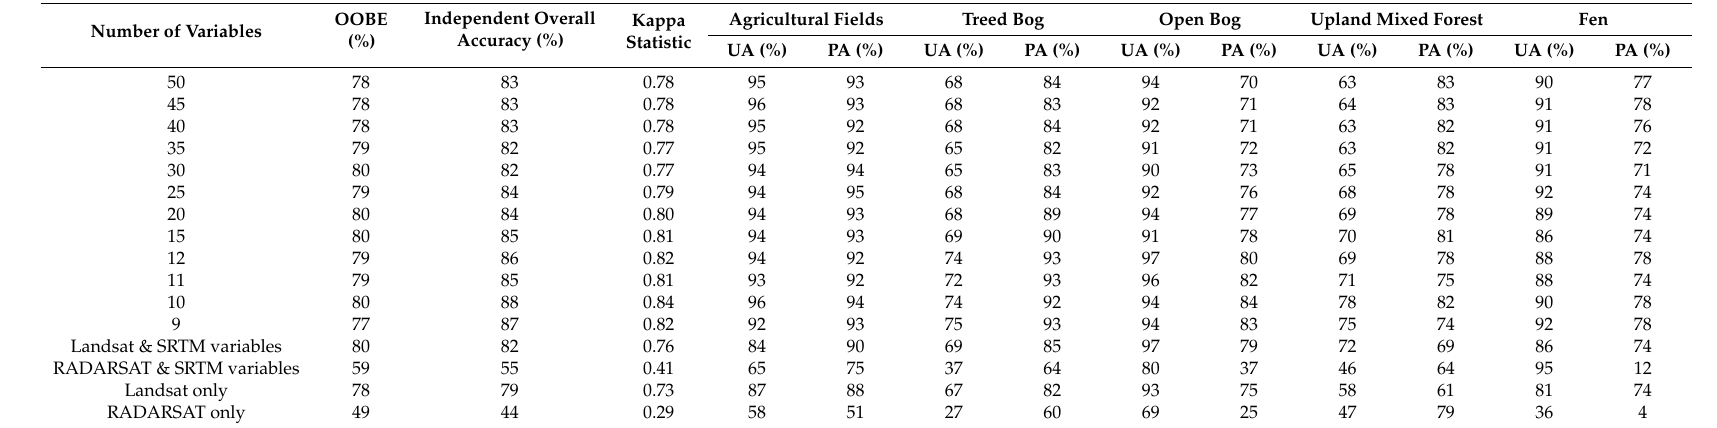
Table A1. Statistical results from the RADARSAT-2 (2 May 2014), Landsat-8 (24 April 2014), and Shuttle Radar Topographic Mission (SRTM) variables spring model. The first iteration was run with all 50 variables, and variables ranked to be unimportant were then removed until 9 variables remained. The final variables in the model with the highest independent overall accuracy (10 variables) in order of decreasing importance were the seven Landsat-8 bands, Entropy from Claude–Pottier, SRTM DEM, and the polarimetry from the Shannon